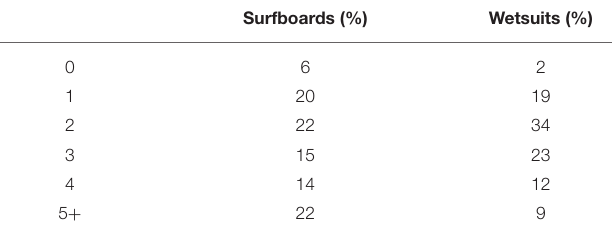
TABLE 4 | What is most important for you when you buy surfboards and wetsuits? (maximum 2 answers) ( N = 246/249).